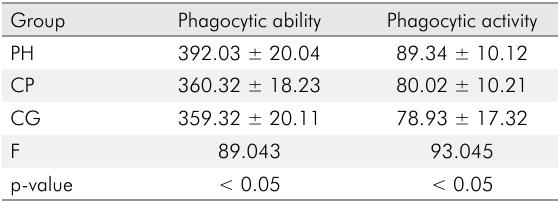
Table 9. Neutrophil phagocytosis